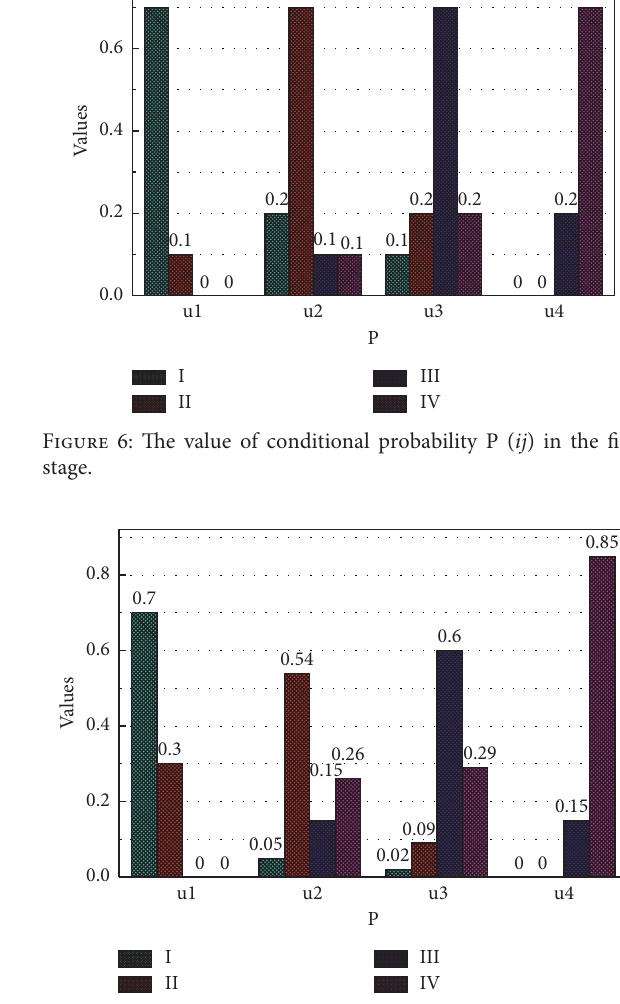
Figure 7: The value of the posterior probability P ( ij ) in the first